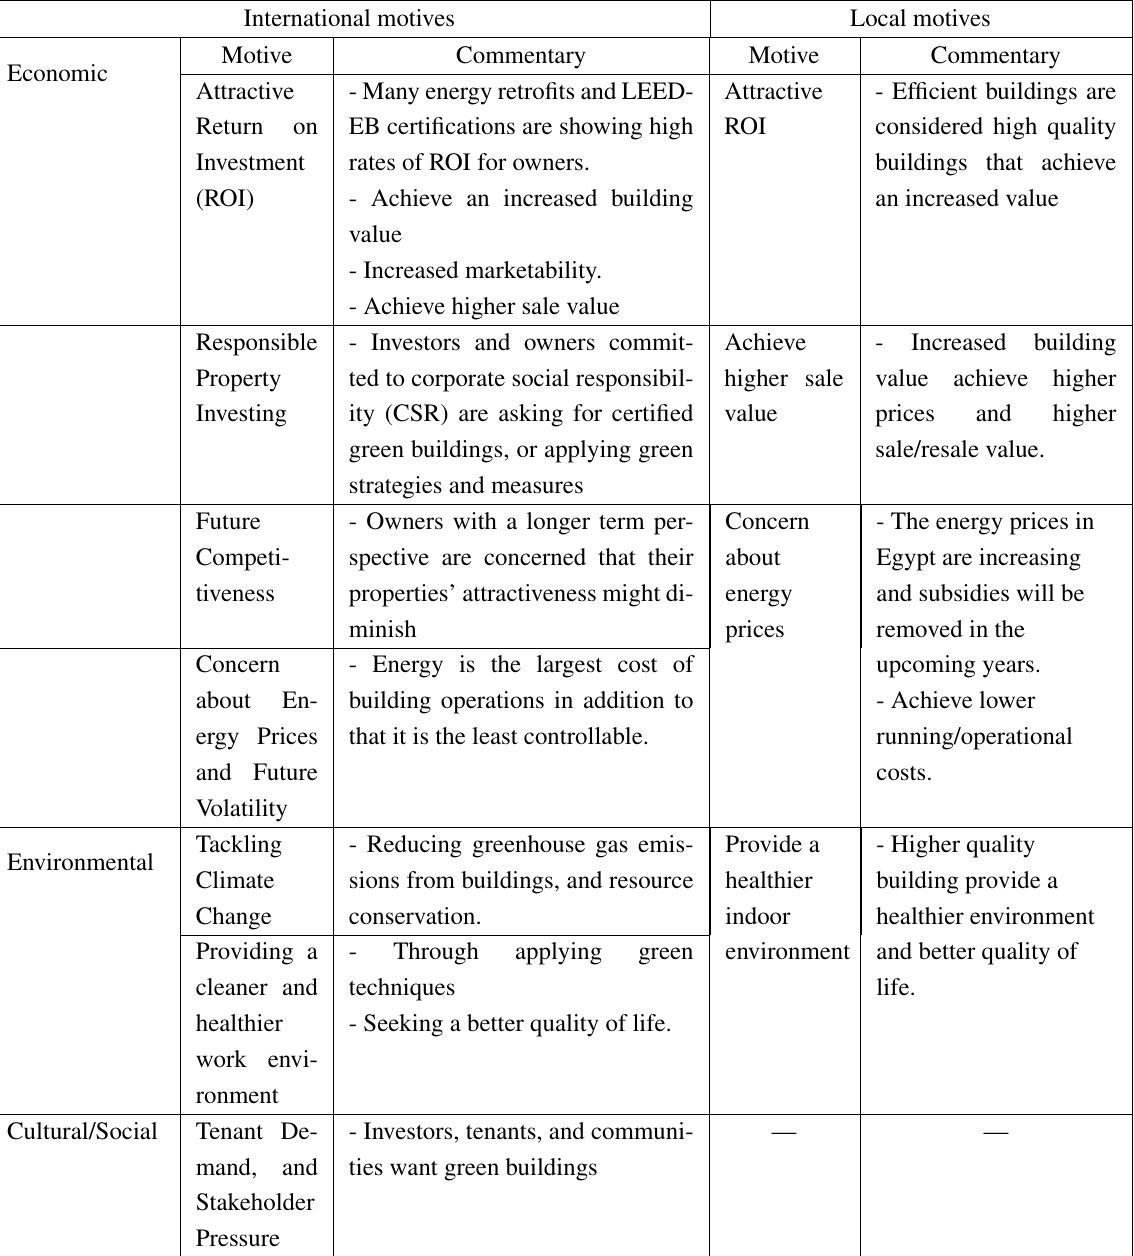
Table 1. Motives to greening existing